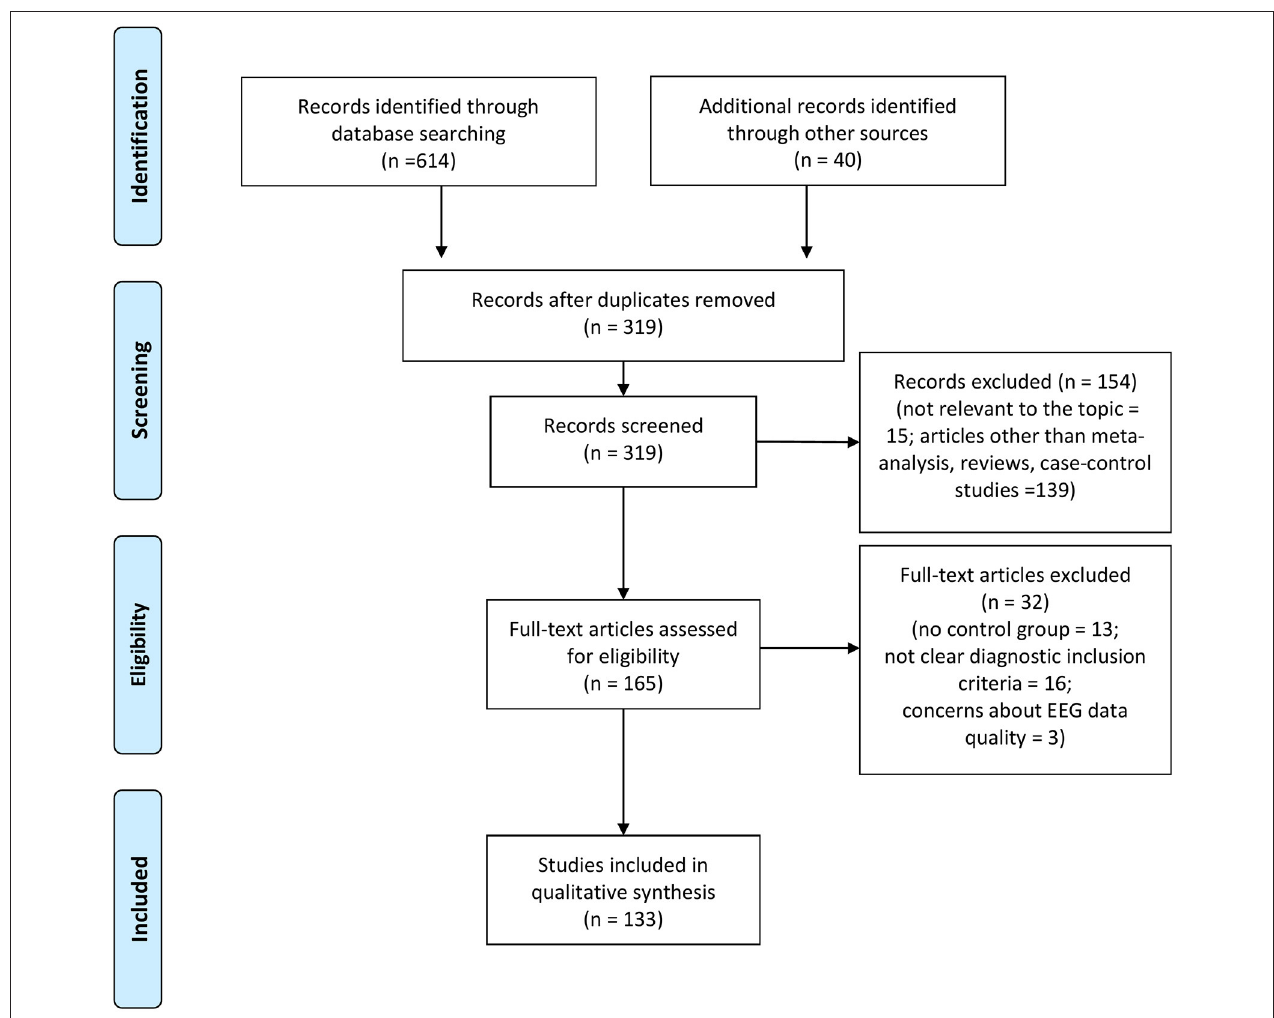
FIGURE 1 | PRISMA flow chart of included